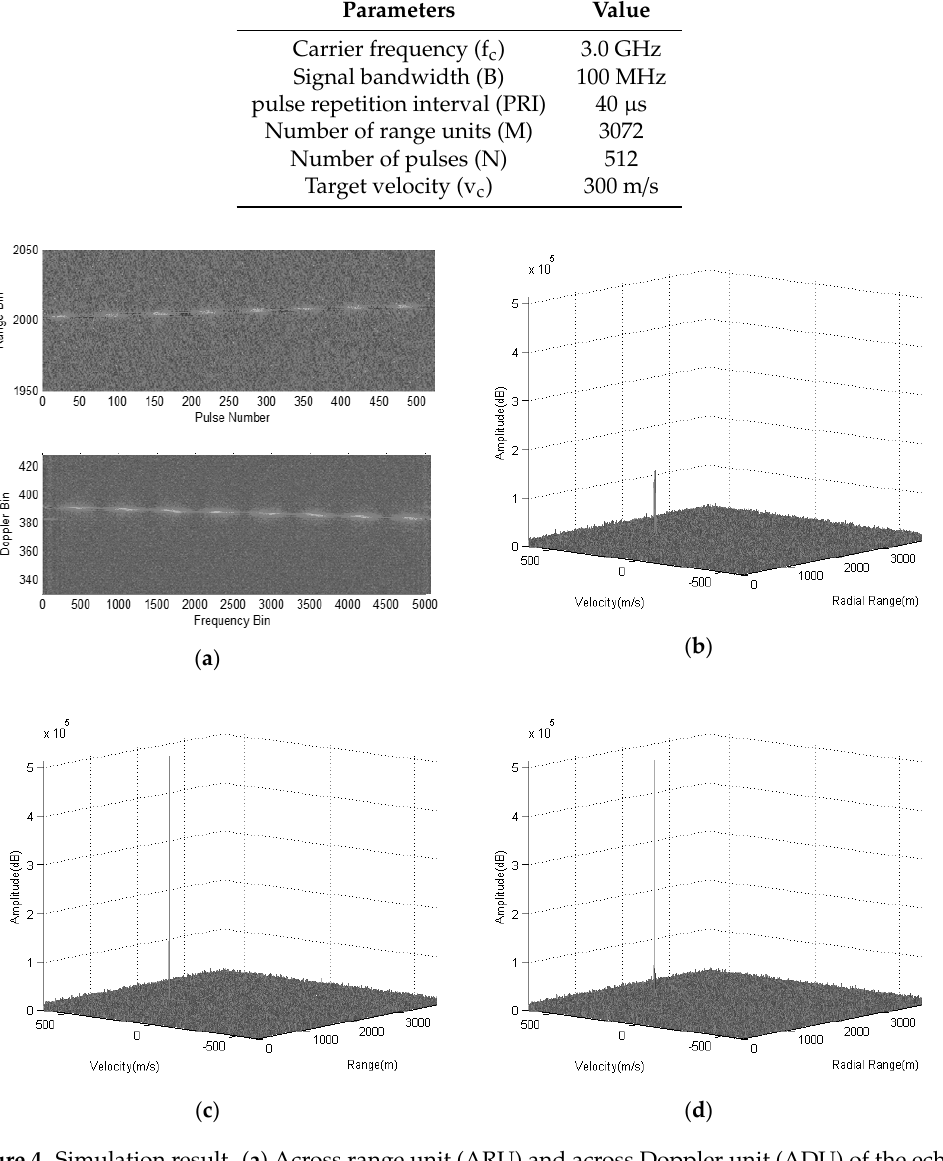
Figure 4. Simulation result. ( a ) Across range unit (ARU) and across Doppler unit (ADU) of the echo data; ( b ) integration result of conventional FFT; ( c ) result of the proposed algorithm; ( d ) result of the proposed fast implementation method.